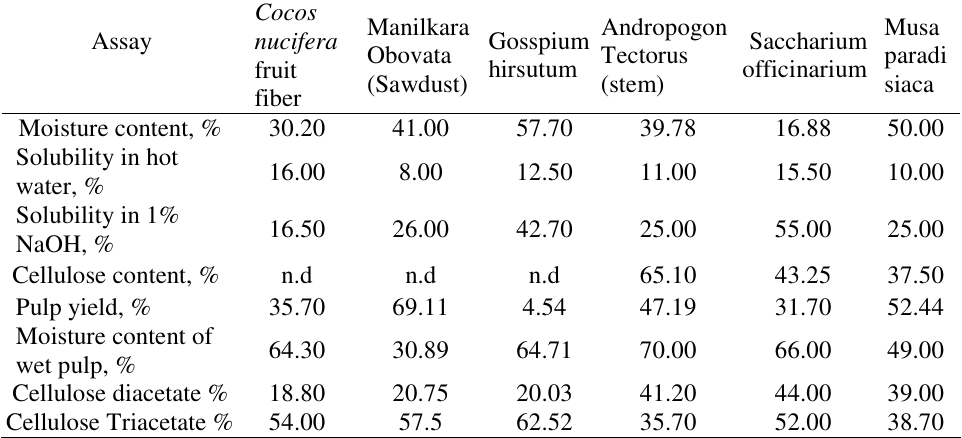
Table 2 . Proximate Composition and Acetate Yield of Some Agricultural Waste